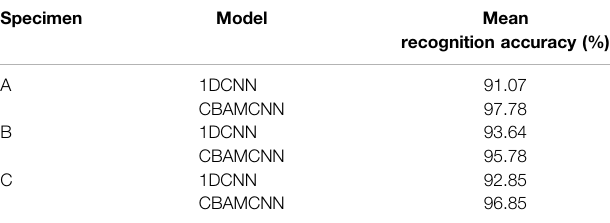
TABLE 3 | Mean recognition accuracy for three different specimens.